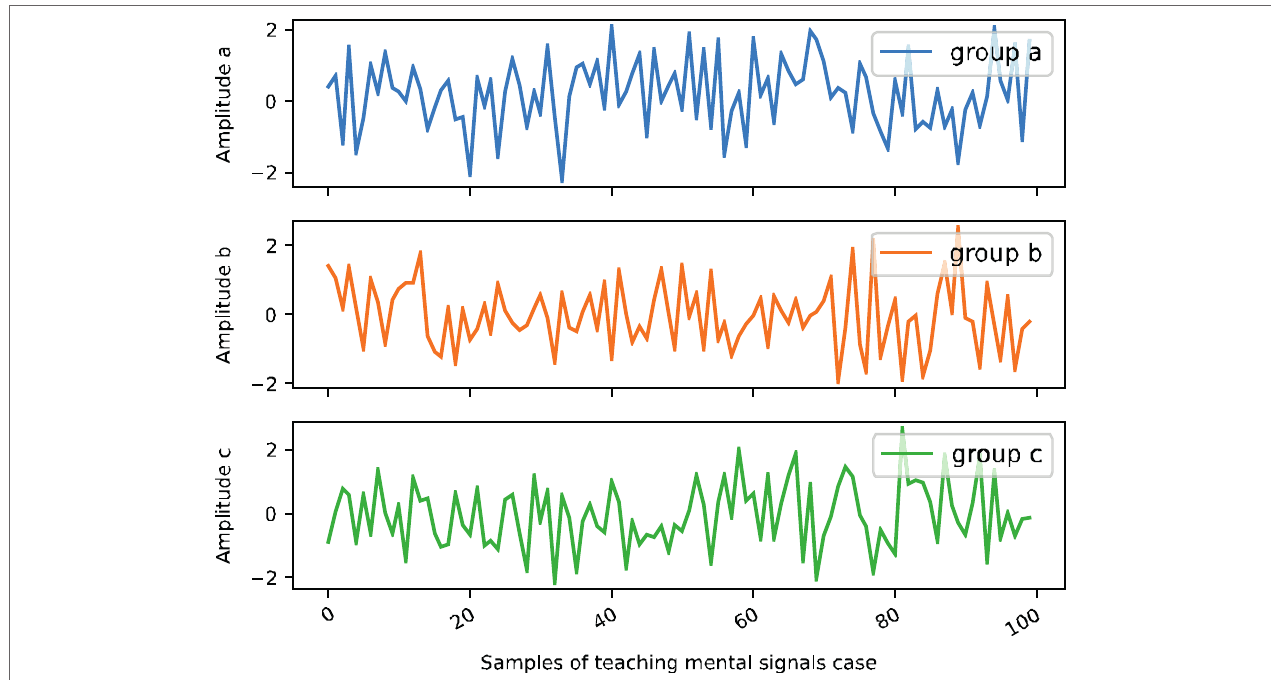
FIGURE 3 | Out-of-sample prediction distribution of teachers’ teaching psychological signals.